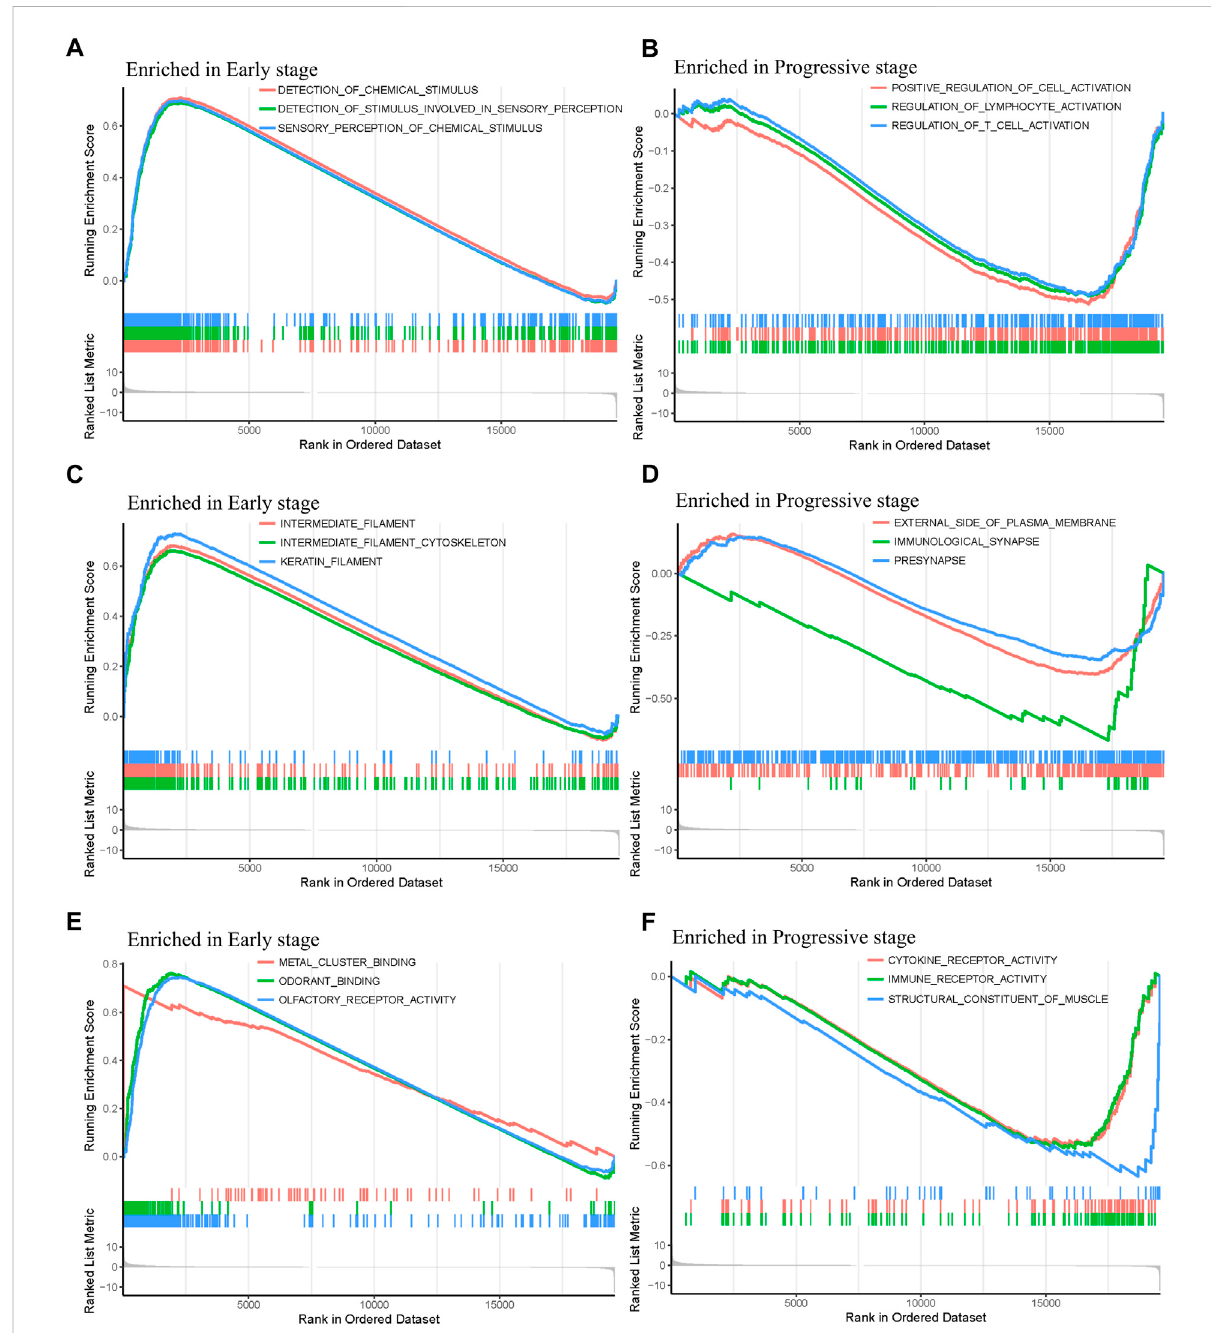
FIGURE 6 GO function annotationsof mRNAs intheearly-and progressive-stageSTAD cohorts via GSEA.The left sideofthe fi gure refers to theenriched annotations in the early-stage group, while the right side refers to the enriched annotations in the progressive-stage group. From top to bottom of this fi gure are biological process (BP) (A,B) ; cellular component (CC) (C,D) ; and molecular function (MF)